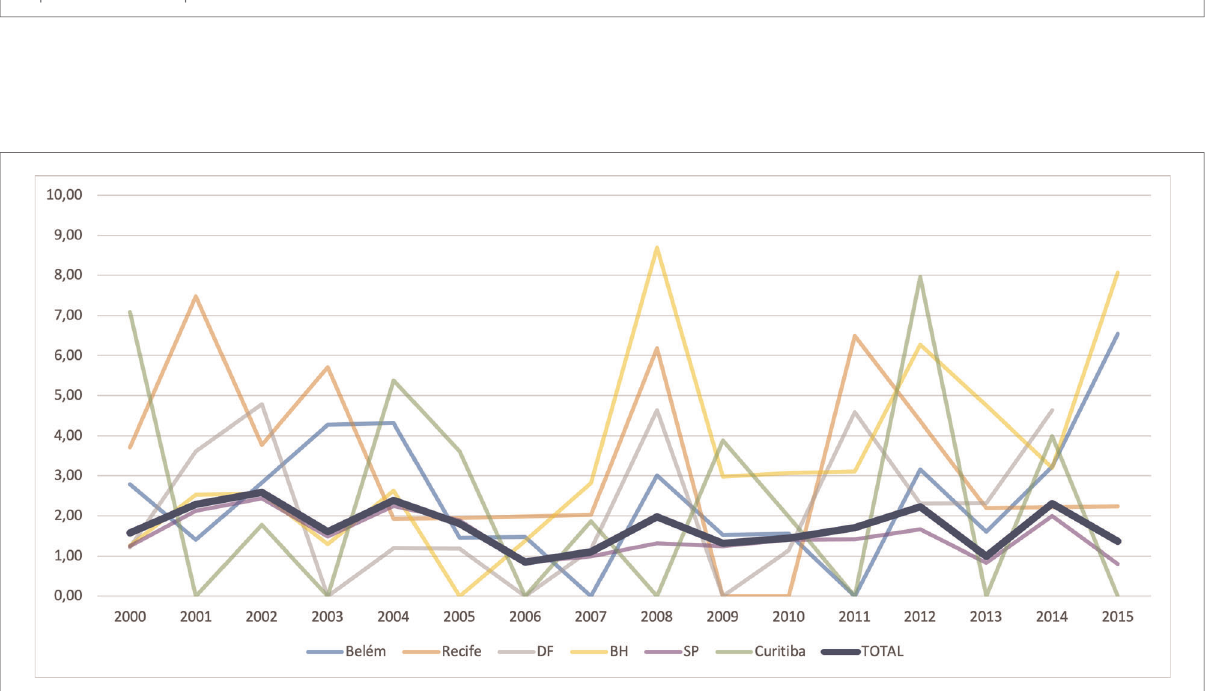
FIGURE 3 Retinoblastoma incidence rate per 1 million children and adolescents (0 to 19 years old), adjusted for age, according to sex and PBCR, in their respective reference periods.